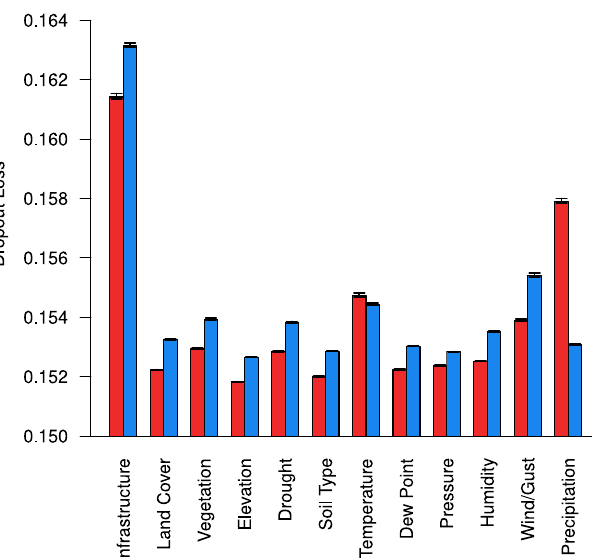
Figure 5. Grouped variable importance as measured by dropout loss (RMSLE) over 10 iterations of permuted groups of variables. The 95% confidence intervals are also shown for both the RTMA-based outage model (red, ( left )), and the WRF-based outage model (blue, ( right